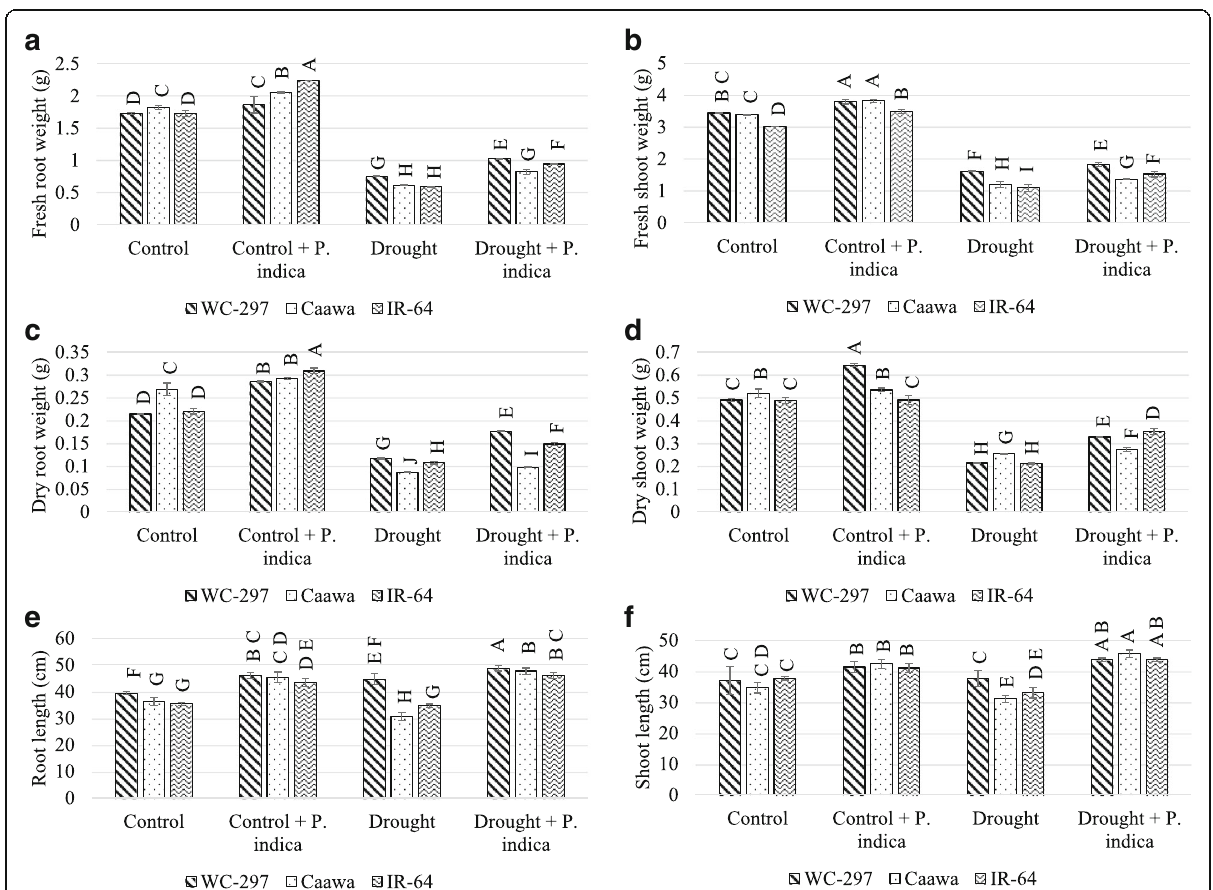
Fig. 2 Gain in biomass and length of root and shoot of rice seedlings. The inoculation with P. indica increased the plant biomass and the length of root and shoot. a Gain in fresh root weight. b fresh shoot weight c dry root weight d dry shoot weight e root length and f shoot length. Alphabetic on the top of each bar are showing the LSD 0.05